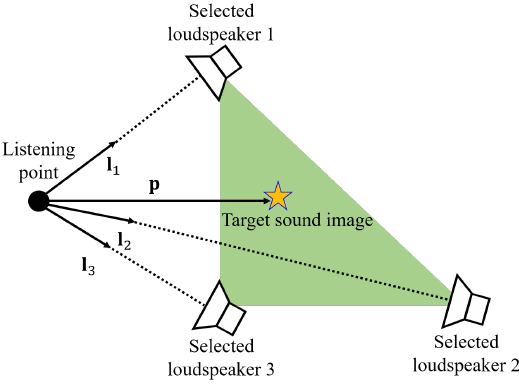
Figure 3. Overview of vector base amplitude panning